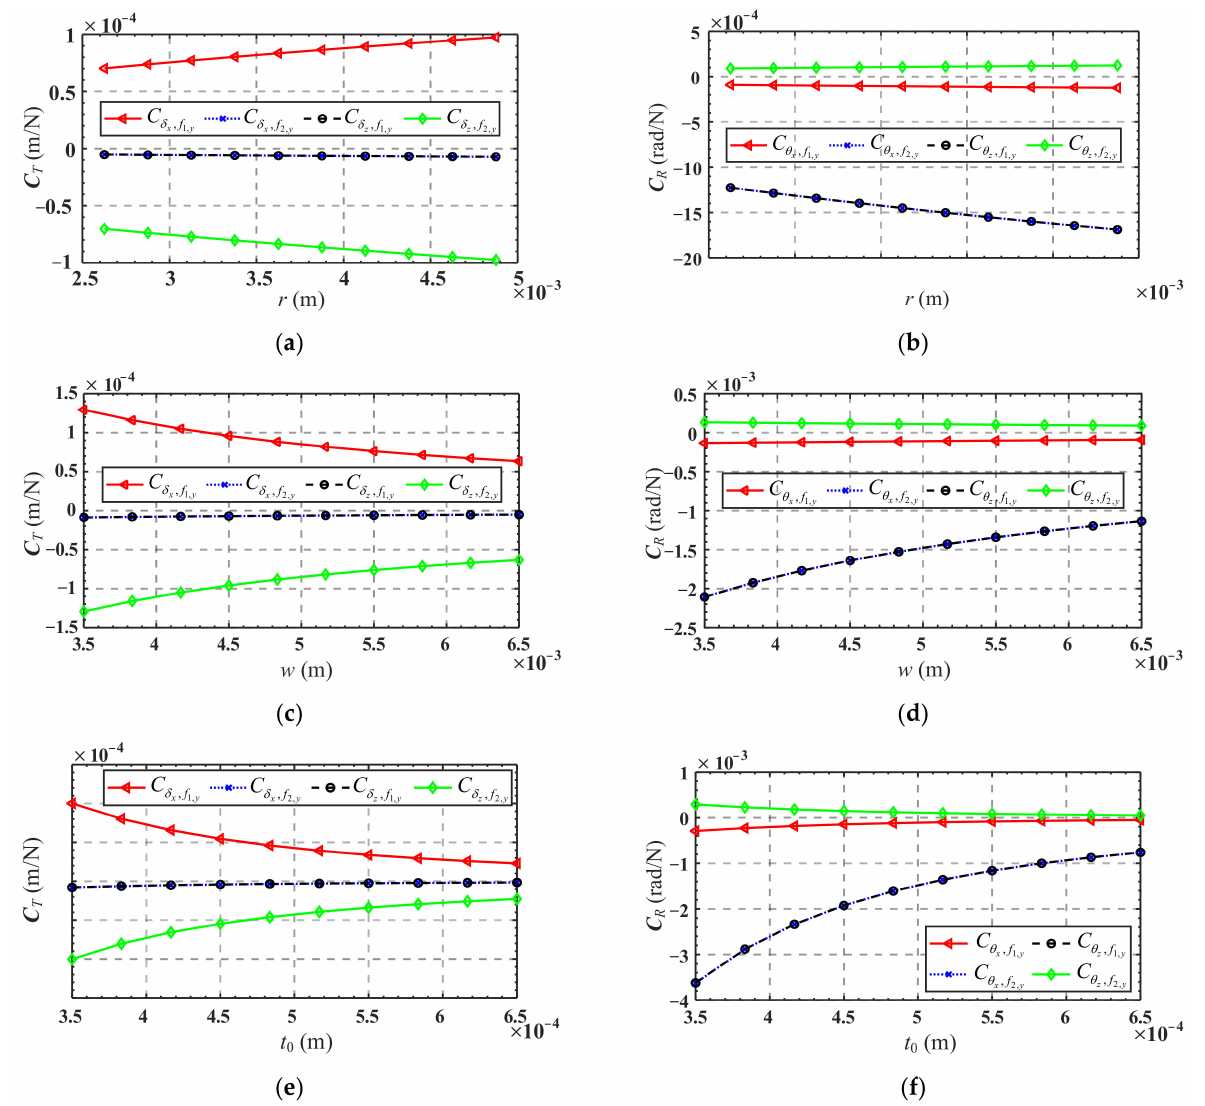
Figure 16. Variation of mapping matrix C T and C R in terms of flexure hinge structure parameters: ( a ) variation of C T in terms of the parameter r ; ( b ) variation of C R in terms of the parameter r ; ( c ) variation of C T in terms of the parameter w ; ( d ) variation of C R in terms of the parameter w ; ( e ) variation of C T in terms of the parameter t 0 ; ( f ) variation of C R in terms of the parameter t 0